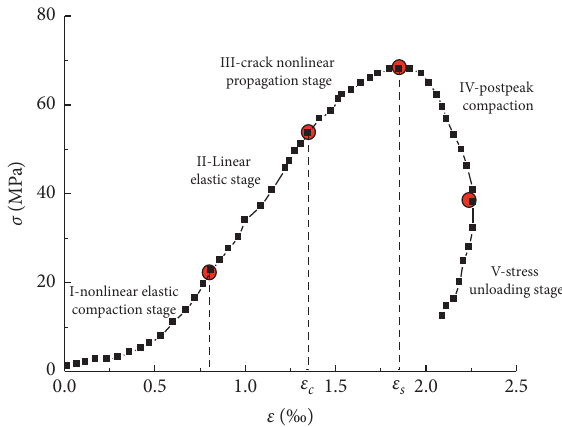
Figure 6: Typical stress-strain curve under dynamic test ( ω � 2.53%, sample-2). ε c and ε s are strains at yielding strength and peak strength, respectively.